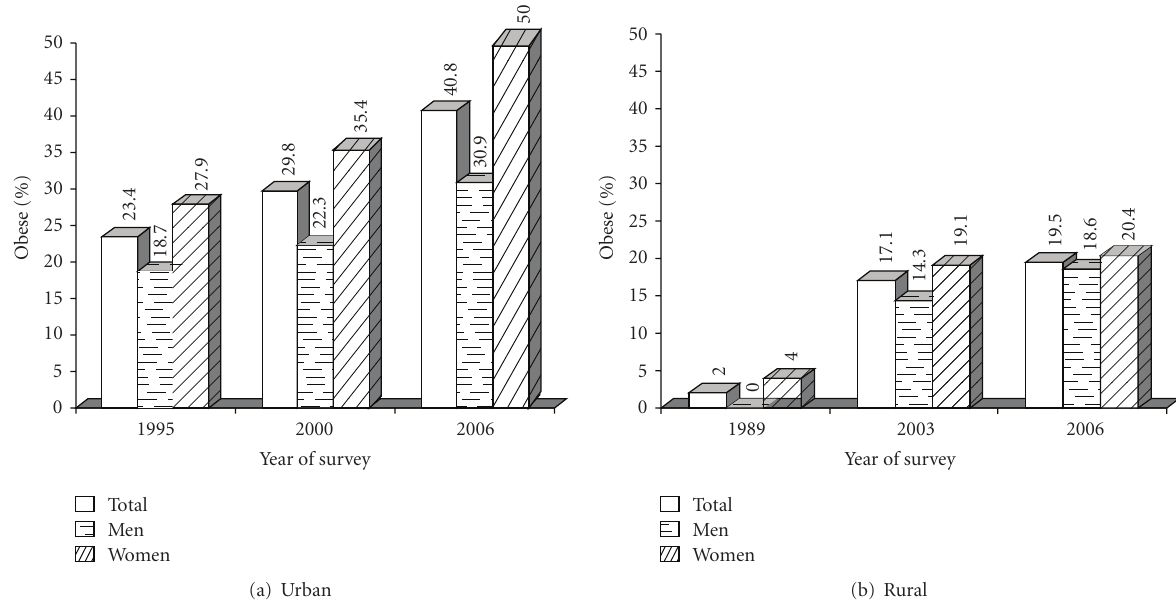
Figure 1: Temporal changes in prevalence (%) of obesity ( ≥ 25 kg/m 2 ) among urban and rural Asian Indians. The results are based on epidemiological data collected in [22–24]. (a) Shows the data for urban population. (b) Shows the data for rural